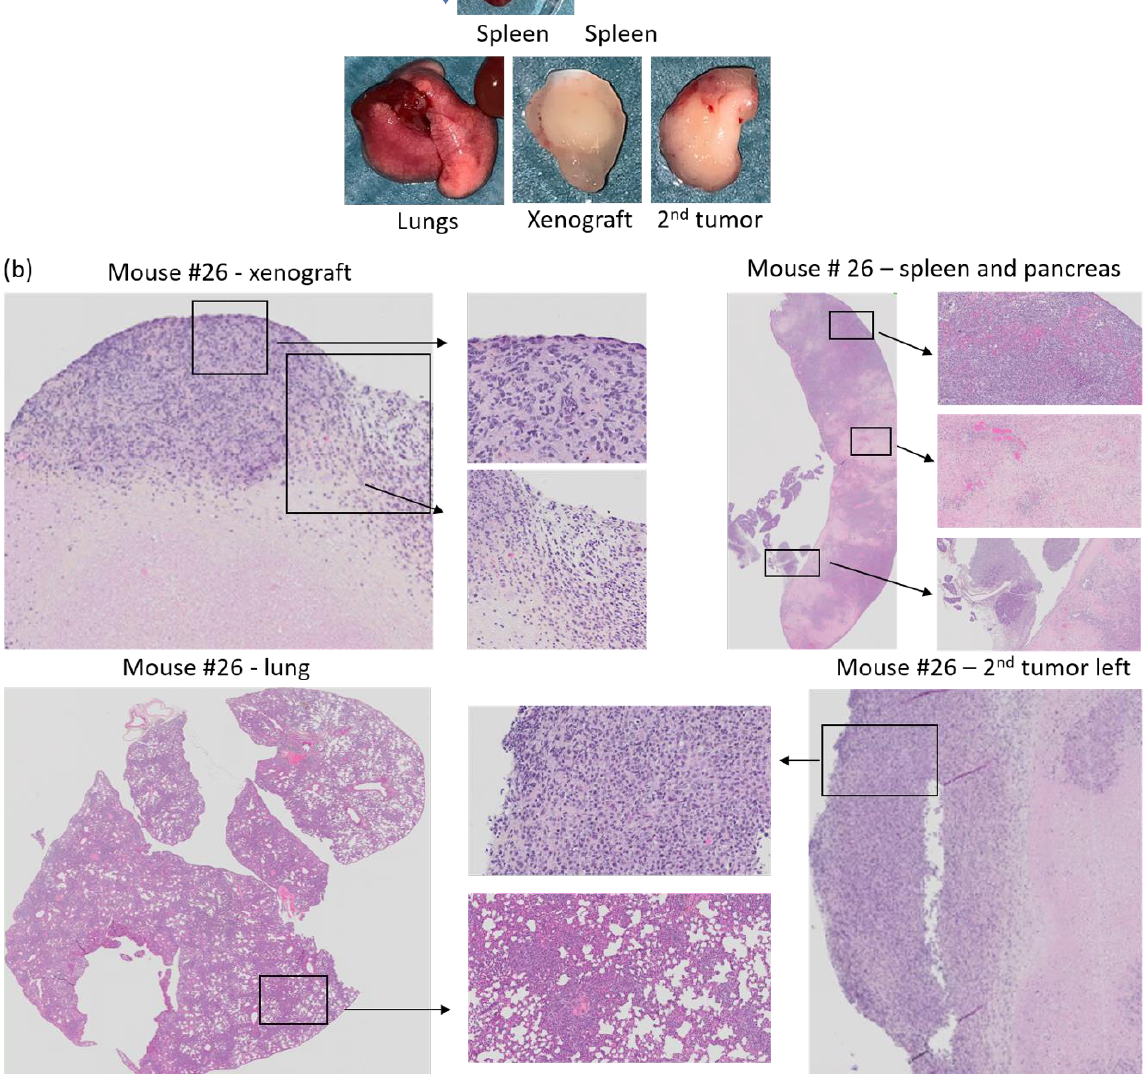
Figure 13. ( a ) Tissue collected at necroscopy from mouse #26 and spleen from mouse #12 and ( b ) HES staining of PDX, spleen, second tumor left shoulder, and lung from mouse #26. Xenograft; necrotic tissue surrounded by lymphoid cancer cells. Spleen/pancreas; lymphoid cancer cells and pale necrotic tissue areas in the spleen. Lung; dense areas with lymphoid cancer cells. Secondary tumor left shoulder; compact tumor with lymphoid cancer cells.